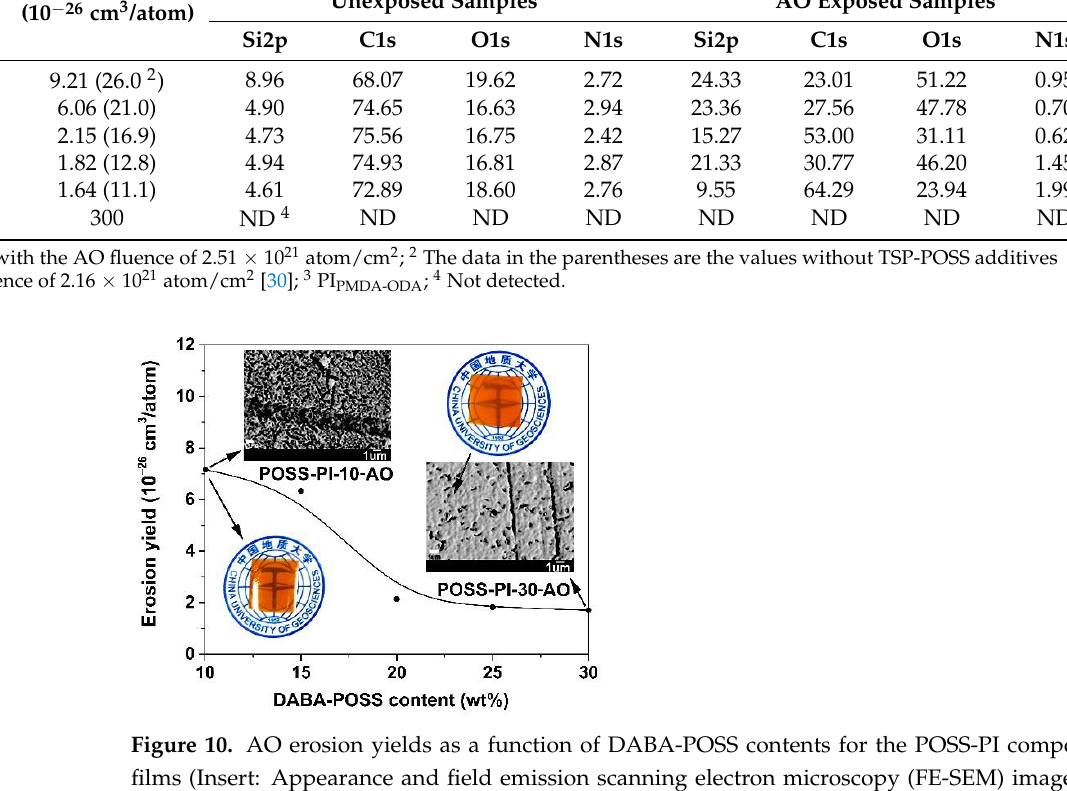
Figure 11. X-ray photoelectron spectroscopy ( XPS) spectra of POSS-PI composite films. ( a ) Before AO exposure; ( b ) After AO exposure. Table 4. XPS results for the unexposed and exposed POSS-PI composite films. Samples